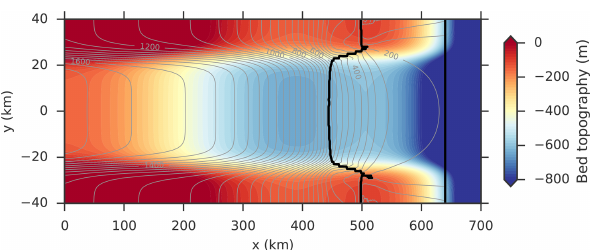
Figure 1. Top view of channel-type bed topography (Asay-Davis et al., 2016; Cornford et al., 2020) used in this study. It is character- ized by an overdeepening (retrograde bed section) in x direction on which the grounding line (black contour) of the spun-up ice-sheet- shelf system has a stable steady-state position. Gray contours rep- resent ice thickness in 50m steps. The fixed calving front is shown by the straight black contour at x =